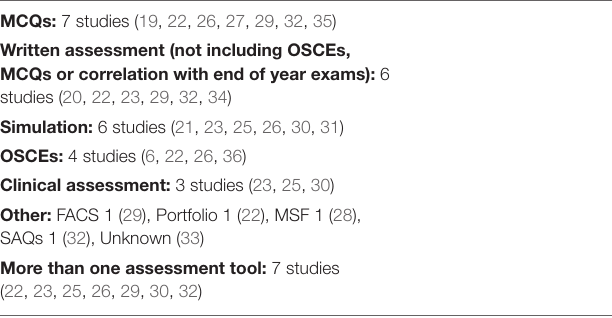
TABLE 2 | Assessment tools used following clinical placements in Anaesthesia and Intensive Care Medicine. MCQs: 7 studies (19, 22, 26, 27, 29, 32, 35) Written assessment (not including OSCEs, MCQs or correlation with end of year exams): 6 studies (20, 22, 23, 29, 32, 34) Simulation: 6 studies (21, 23, 25, 26, 30, 31) OSCEs: 4 studies (6, 22, 26, 36) Clinical assessment: 3 studies (23, 25, 30) Other: FACS 1 (29), Portfolio 1 (22), MSF 1 (28), SAQs 1 (32), Unknown (33) More than one assessment tool: 7 studies (22, 23, 25, 26, 29, 30, 32) MCQs, multiple choice questions, OSCEs, objective structured clinical examinations; FACS, formative assessment case studies; MSF, multisource feedback; SAQs, short answer